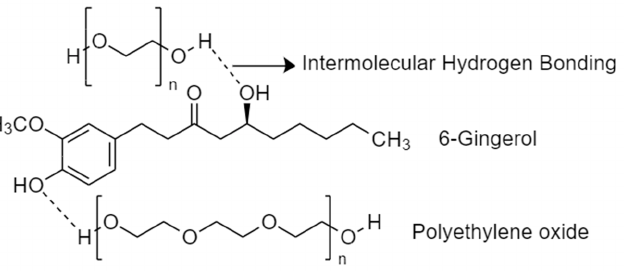
Figure 7. Schematic representation of hydrogen bonding between PEO and 6-Gingerol . 4.4. Nanofibre Morphological Analysis The morphology of nanofibres depends on the solution (solvent, molecular weight, concentration, viscosity, and temperature) and electrospinning process parameters (spin- neret type and geometry, collector type, applied voltage, distance between collector, and spinneret) [71–74]. Figure 8 shows the SEM images and histograms of PEO/GE nanofibres electrospun at different PEO concentrations but under the same spinning conditions. SEM